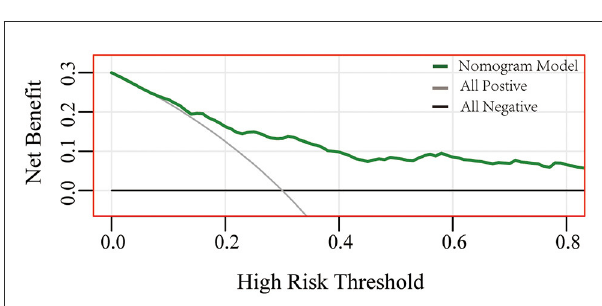
FIGURE4 Performance of decision curve analysis. Decision curve analysis demonstrates the theoretical relationship between the net benefit of the model across different threshold probabilities (12). The horizontal axis represents the threshold risk of twin pregnancies patients who happened to have postpartum hemorrhage. The gray line assumes that all patients happened to postpartum hemorrhage, and the black thin line assumes no patients happened to postpartum hemorrhage. At the same threshold probability, the larger net benefit implies that more benefits patients can achieve using the